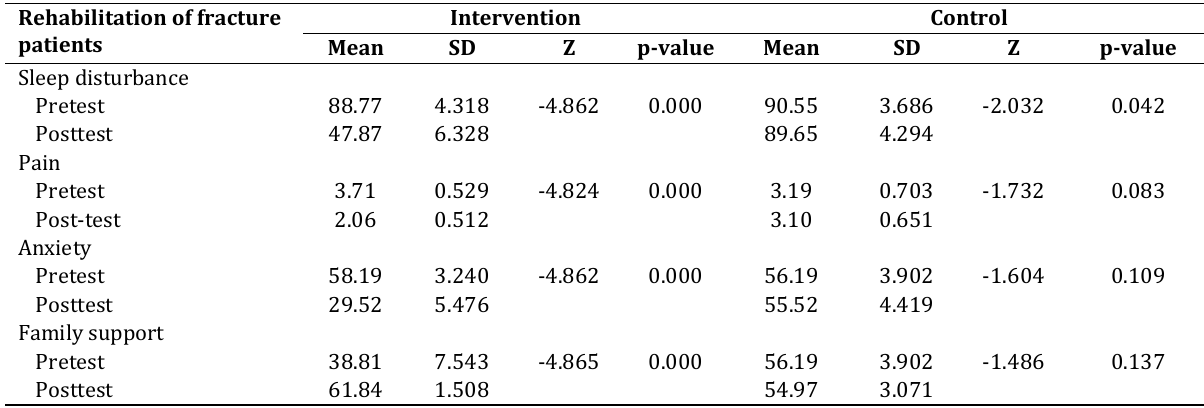
Table 3. The effect of the Levine-based Nursing Intervention on Rehabilitation of Fracture Patients among the Intervention Group and the Control Group (n=62) Rehabilitation of fracture Intervention patients